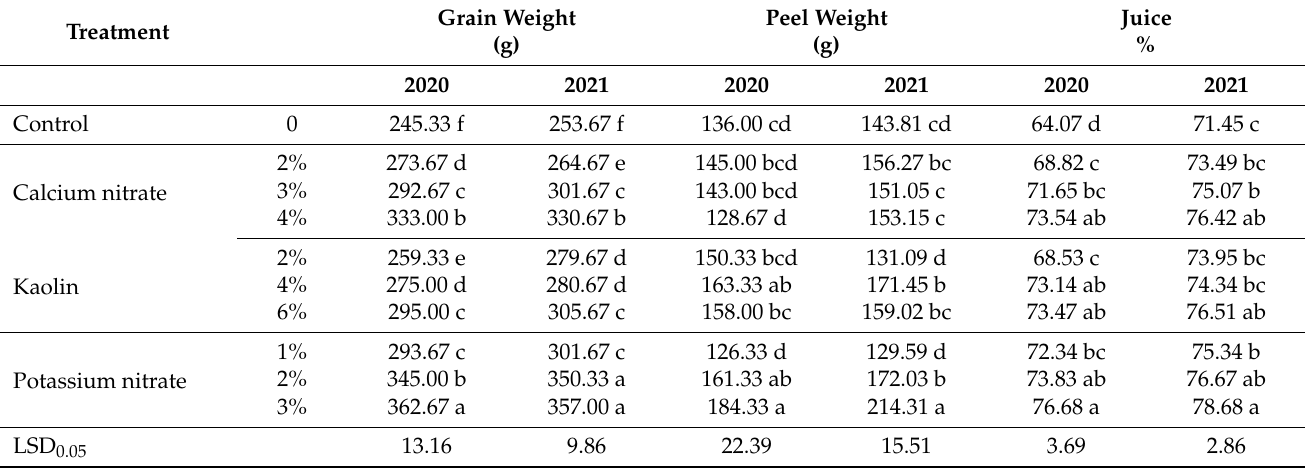
Table 5. The effect of the foliar application of potassium nitrate, calcium nitrate and kaolin on the grain weight, peel weight and fruit juice percentage of ‘Wonderful’ pomegranates during the 2020 and 2021 seasons.